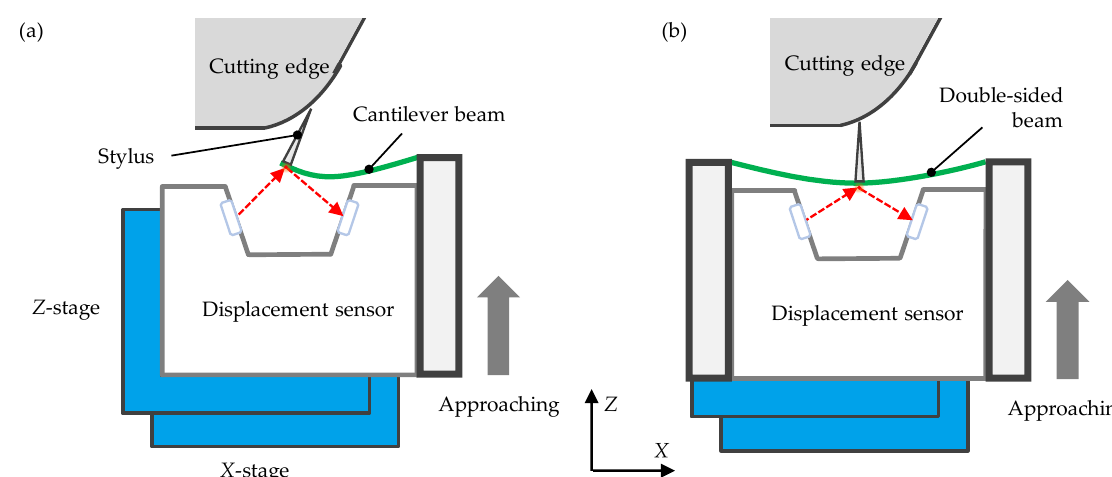
Figure 1. Measurement error caused by undesired deflection: ( a ) Undesired deformation; ( b ) desired deformation.